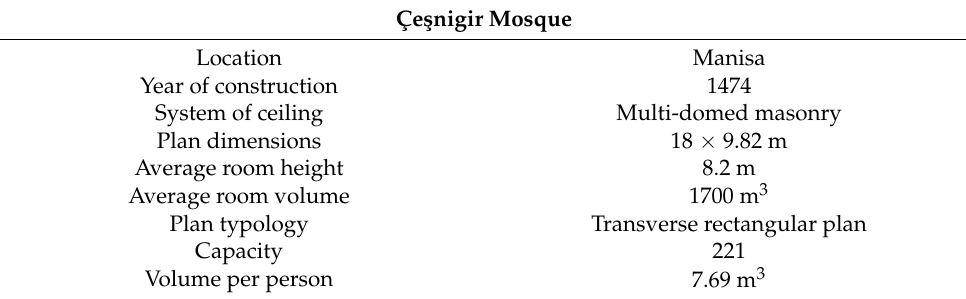
Table 3. The architectural features of Çe¸snigir Mosque.